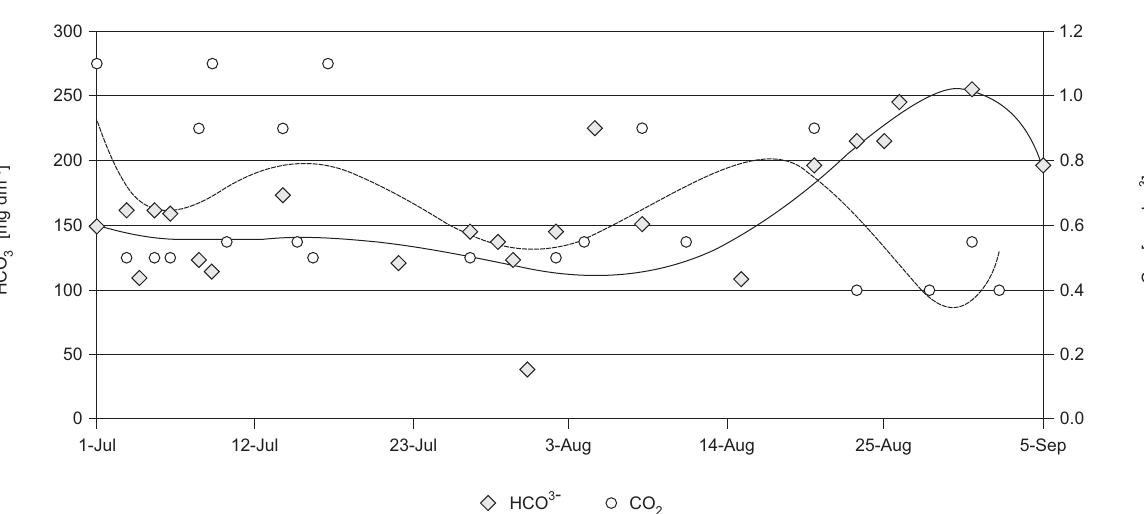
and CO in streams of study river catchments, trends of the 5th and 6th order polynomial 3- 2 the period 1.07–5.09.2004